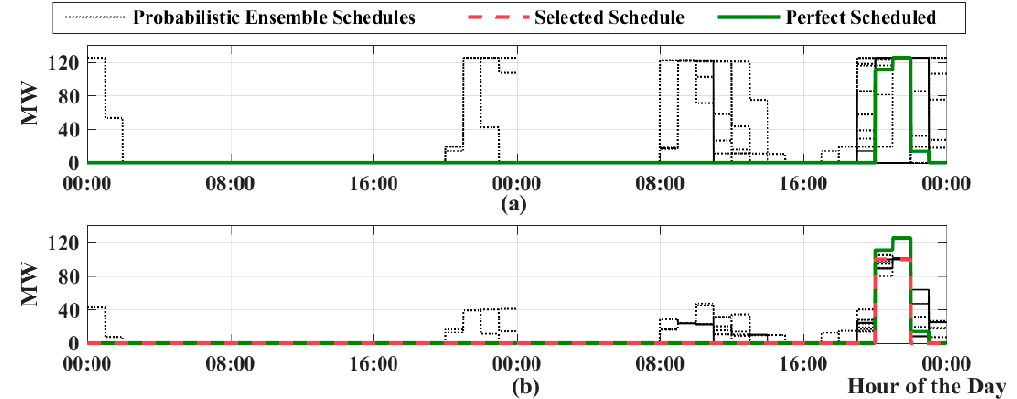
Figure 10. Perfect schedule and forecasted probabilistic schedules without calibration ( a ) and with calibration applied by the uncertainty post-processing, highlighting the selected schedule in red ( b ).